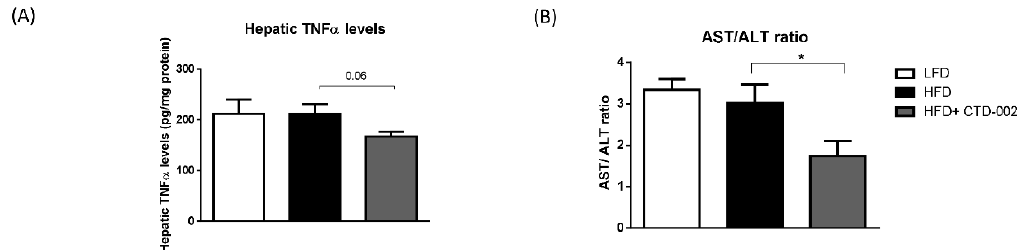
Figure 4. Hepatic TNFα levels and aspartate transaminase/alanine transaminase (AST/ALT) ratio in HFD-fed SD rats treated with or without the extracellular inhibitor of cathepsin D (CTSD). ( A ) Hepatic TNFα levels. ( B ) Plasma transaminase levels. Error bars represent mean ± SEM; n = 6 for each group. * indicates p < 0.05 compared to rats on the HFD.